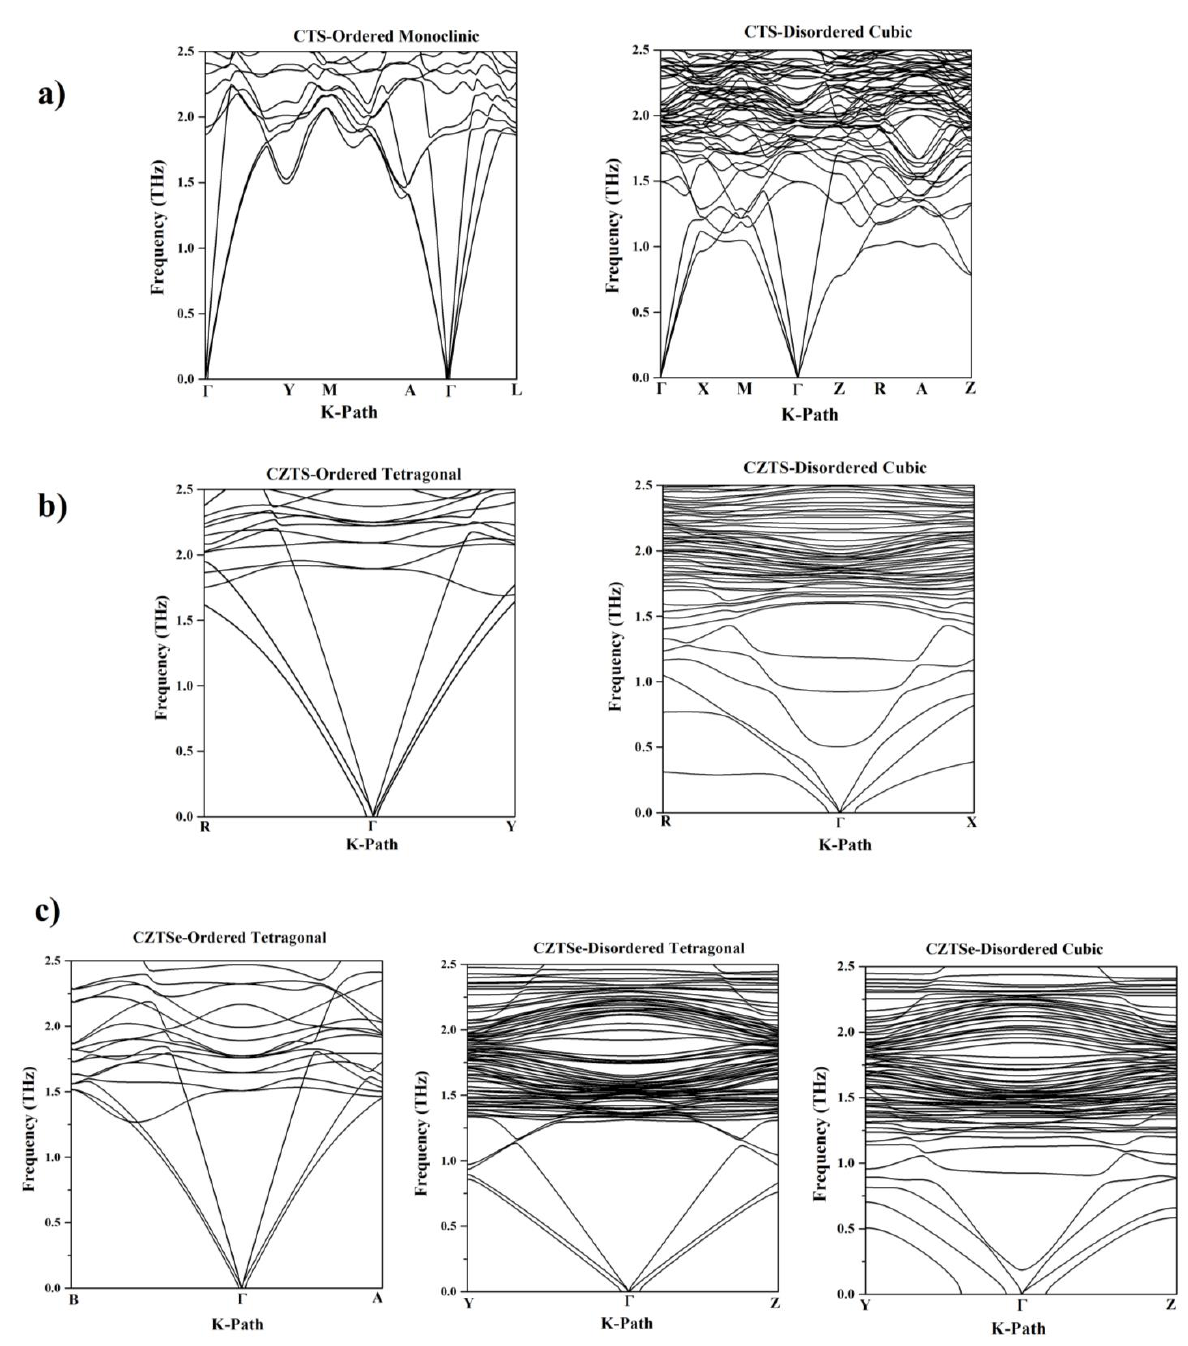
Figure 8. Phonon dispersion curve for CTS ( a ), CZTS ( b ), and CZTSe ( c ) polymorphs. The effect of structural disorder on the phonon dispersion curve manifests itself in the form of a gentle slope of the acoustic branches and the low-lying optical modes.